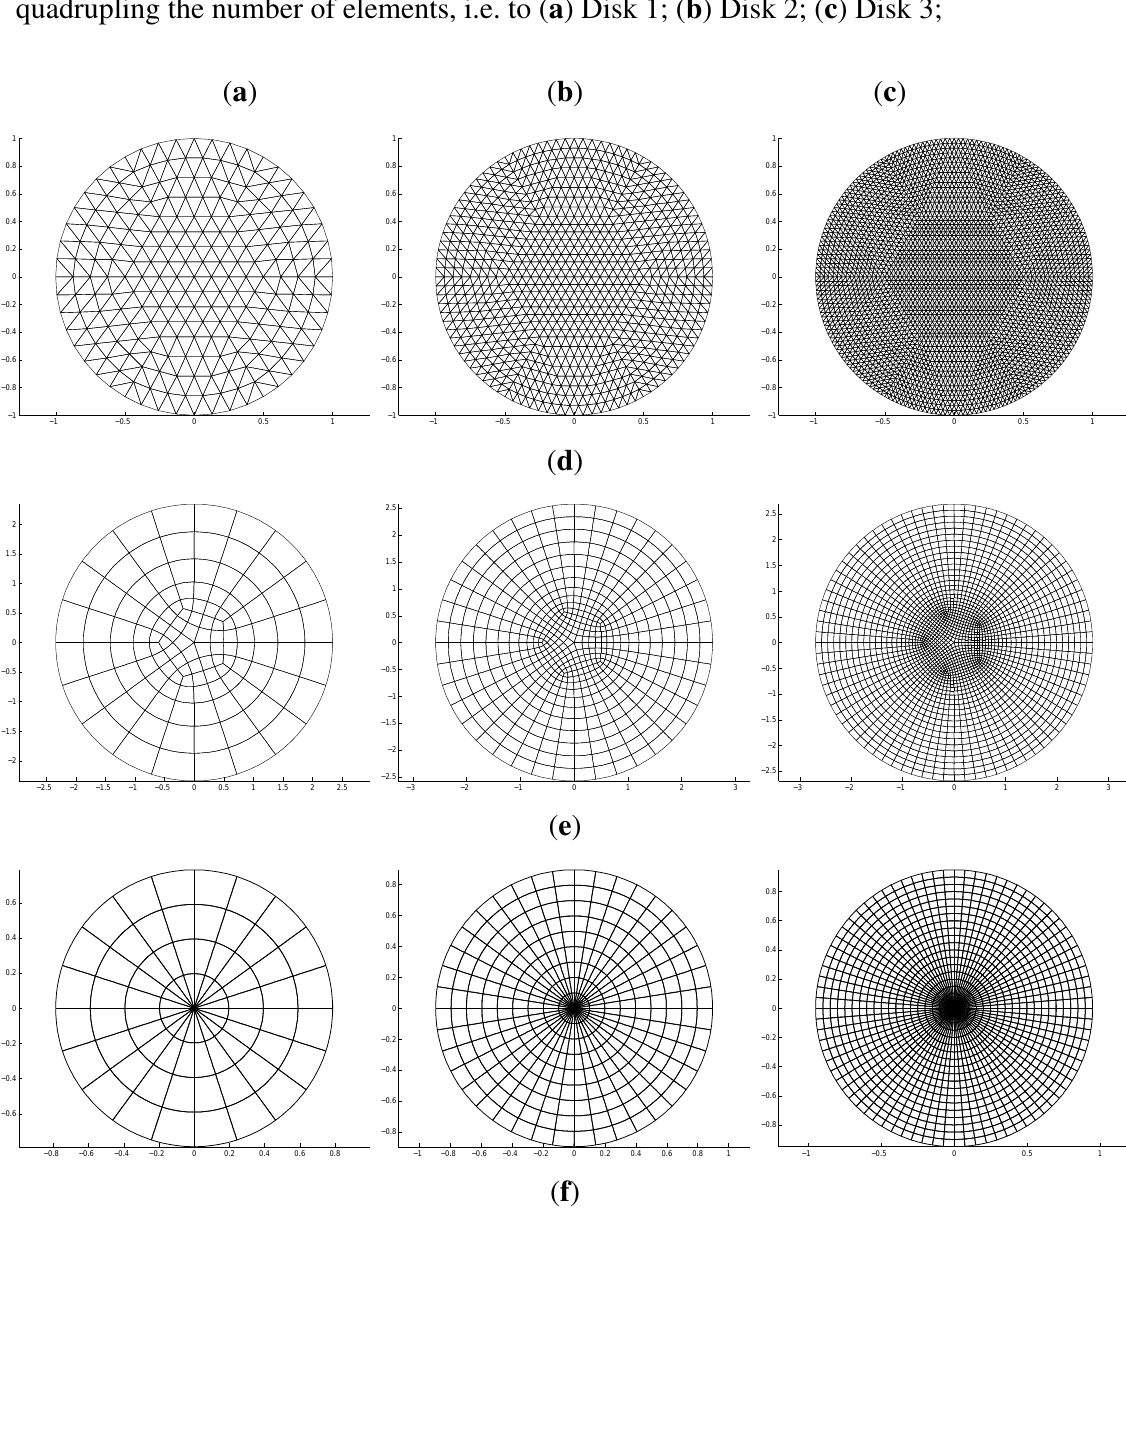
Figure 9. Three types of meshes specific to each of the three classes of methods. ( d ) C 0 quadratic, HCT, DDG elements: 384, 384 × 4 , 384 × 16 elements; ( e ) bi-3 C 0 , Catmull–Clark and G 1 bi-3/bi-5 elements: 120, 120 × 4 , 120 × 16 elements; ( f ) polar C 1 elements: 100, 100 × 4 , 100 × 16 elements. Columns a , b , c correspond to refinement by halving h , hence quadrupling the number of elements, i.e. to ( a ) Disk 1; ( b ) Disk 2; ( c ) Disk